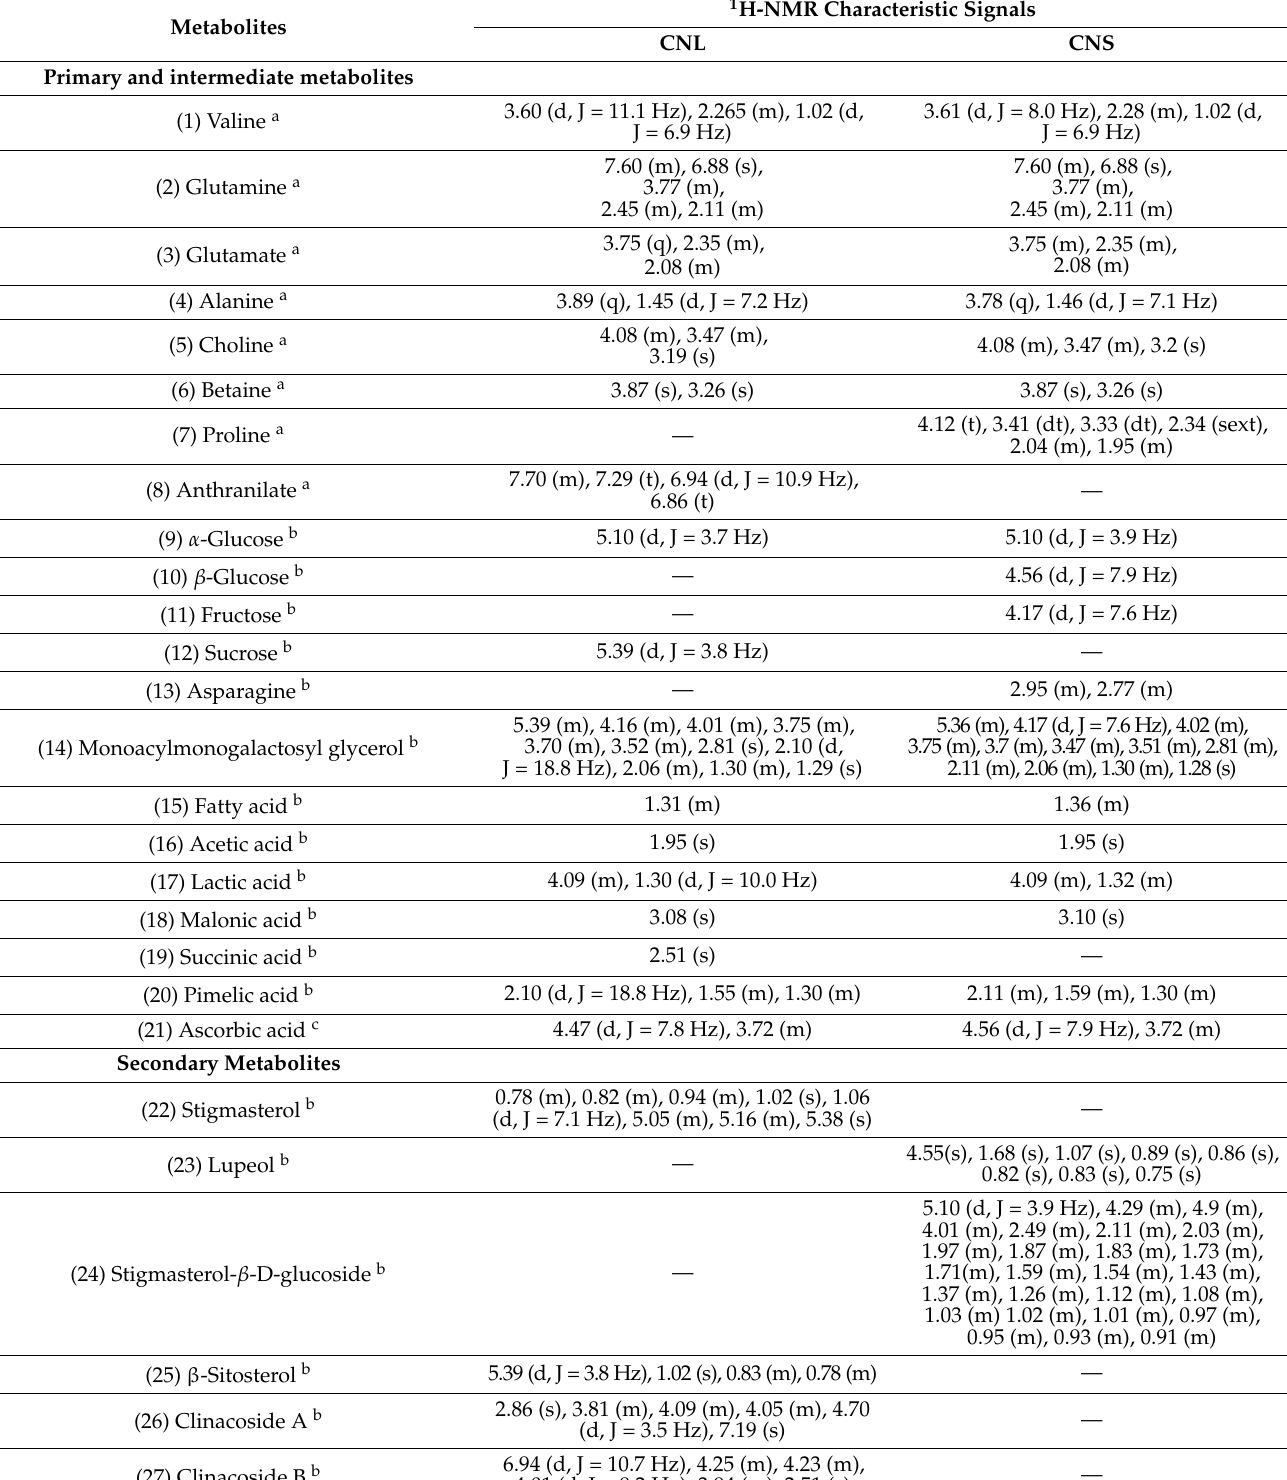
Table 3. 1 H NMR characteristic signals of identified metabolites in Clinacanthus nutans